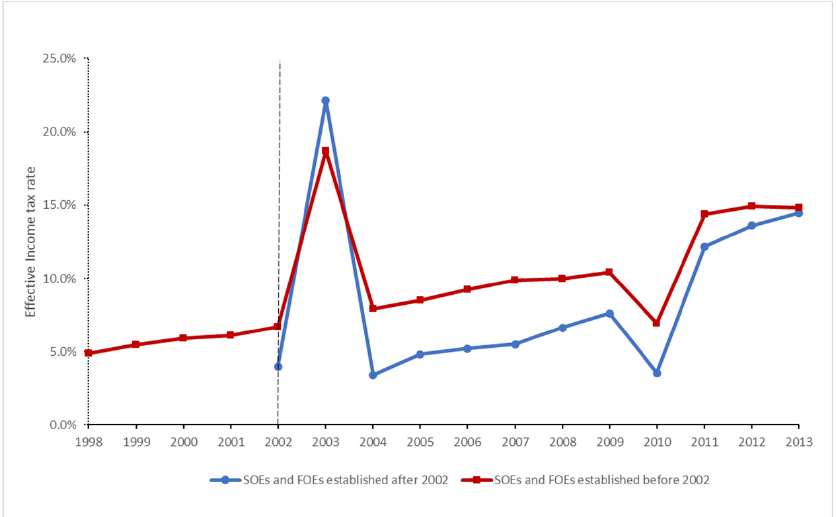
Figure 3. The effective corporate income tax (CIT) rates of state-owned enterprises (SOEs) and for- eign-owned enterprises (FOEs) established before and after the reform.